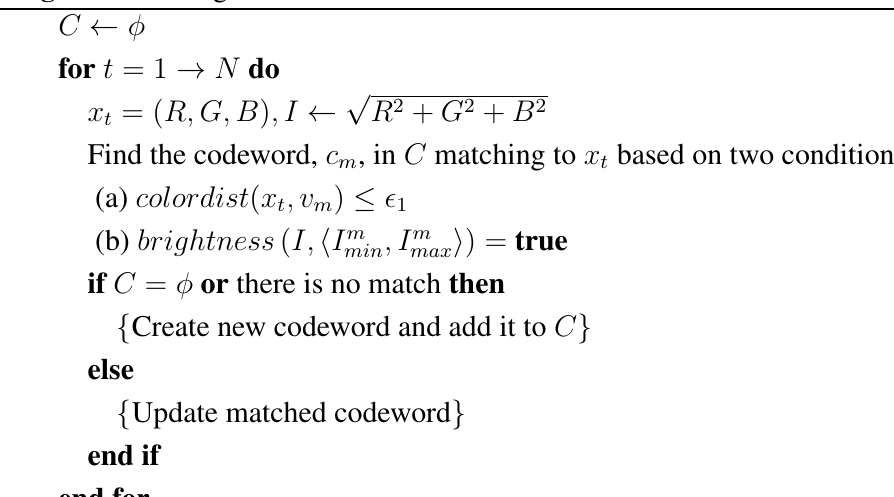
Algorithm 1 : Algorithm for codebook